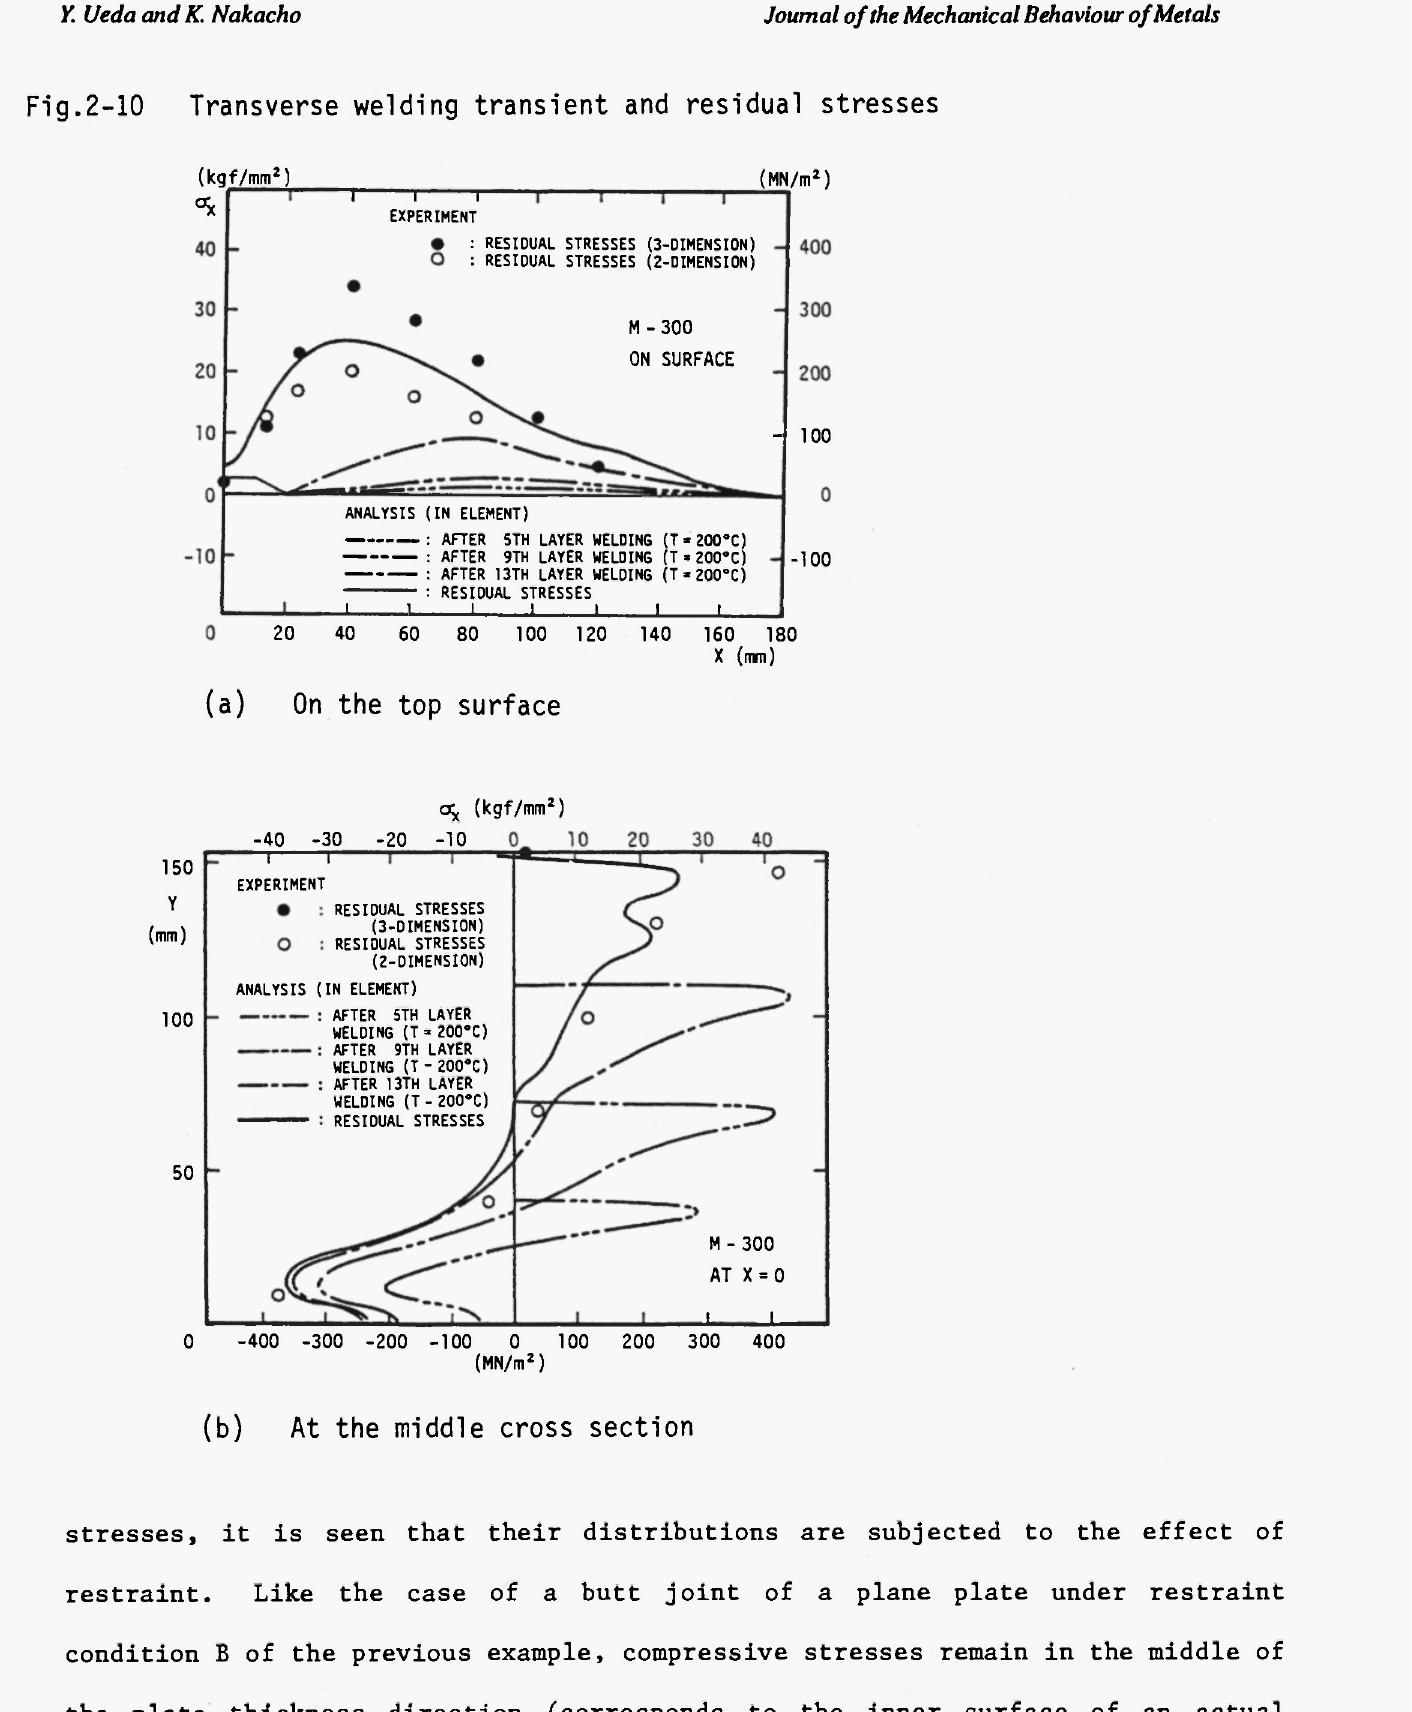
Fig.2-10 Transverse welding transient and residual stresses (kgf/mm 2 ) (MN/m 2 ) Γ EXPERIMENT : RESIDUAL STRESSES (3-DIMENSION) : RESIDUAL STRESSES (2-DIMENSION) Μ-300 ON SURFACE - 100